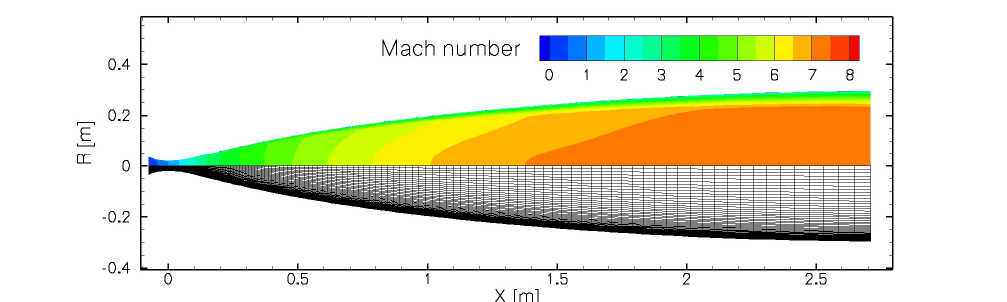
Figure 9: CFD grid and Mach number contours for the HEG nozzle flow (Condition H3.3R3.7). A reservoir-pressure inflow boundary condition is used at the subsonic inflow of the nozzle. The thermodynamic conditions at the inflow are computed using isentropic expansion from prescribed nozzle stagnation conditions using the inflow velocity vector which is part of the CFD solution. The nozzle supply conditions for the considered HEG operating condition H3.3R3.7 is given in Table 2. The chemical non-equilibrium 5 species and 17 reactions rate set for air proposed by Gupta was applied, see Karl et al. (2008). The considered species are molecular and atomic nitrogen and oxygen (N2, O2, N, O) and nitric oxide (NO). The CFD results are subsequently compared with Pitot pressure and stagnation heat flux measurements on spherical probes and static pressure measurements obtained with the HEG calibration rake.